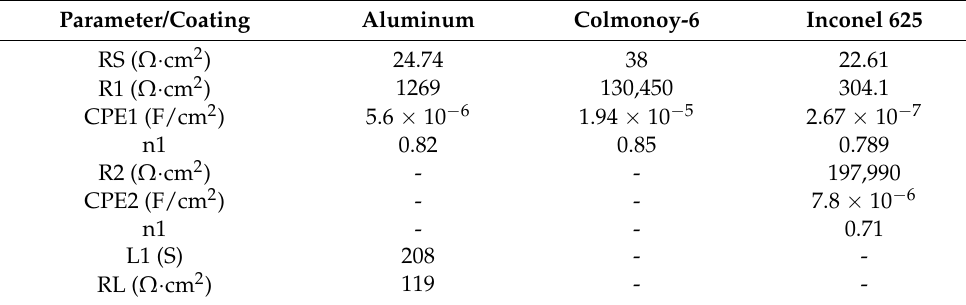
Figure 10. The EIS curves of the coatings at ( a , b ) 40 ◦ C, ( c , d ) 50 ◦ C, and ( e , f ) 60 ◦ C. Table 4. Impedance parameters results calculated for all coatings at 40 ◦ C. The Colmonoy-coated sample’s Nyquist diagram is a semi-loop with a single CPE,